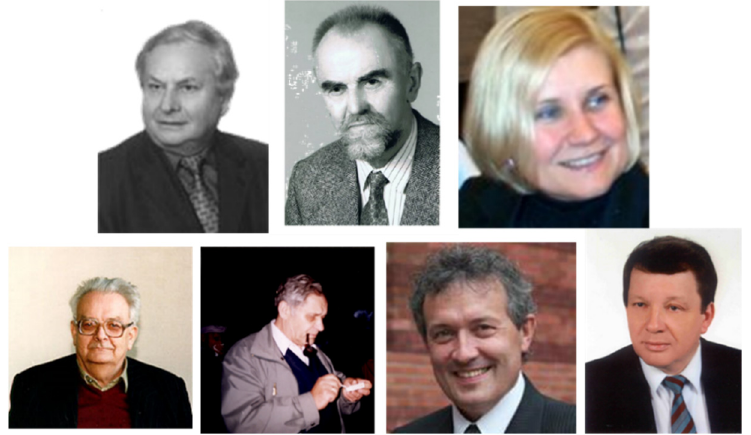
Figure 8. Representation of the Ł ód ź team (top row from the left: T. Paryjczak, E. Bald, J. Ka ł u ż na- Czaplicka. Representatives of the Krakow team: bottom row from the left: L. G ó rski, J. Lasa, A. Grochowalski, P. Ko ś cielniak).